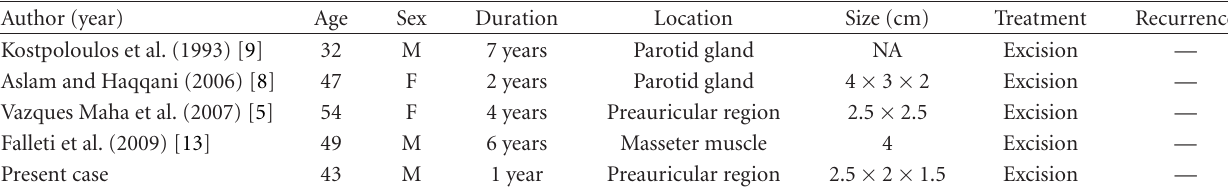
Figure 3: Histopathologically, (a) the tumor consists of hyaline cartilage and collagenous fibrous tissue (H&E stain, × 40). (b) The hyaline cartilaginous tissue contains homogeneous chondrocytes with round nuclei and chondrocytic lacunae (H&E stain, × 200). Table 1: The literature review of extraskeletal chondromas of the parotid